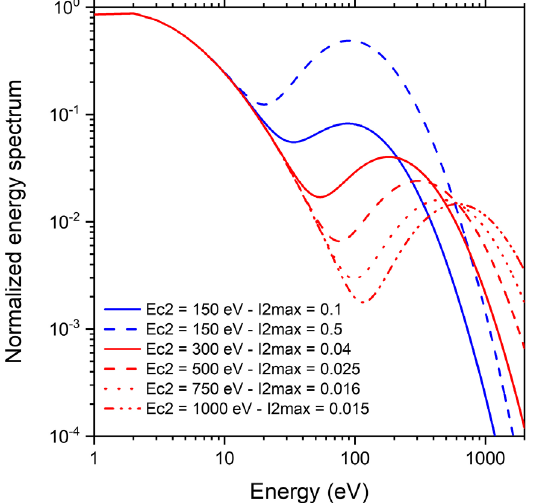
FIG. 13. Energy spectra calculated with different parameters for peak 2 (the position of the peak is displaced at higher energy or its intensity is modified).